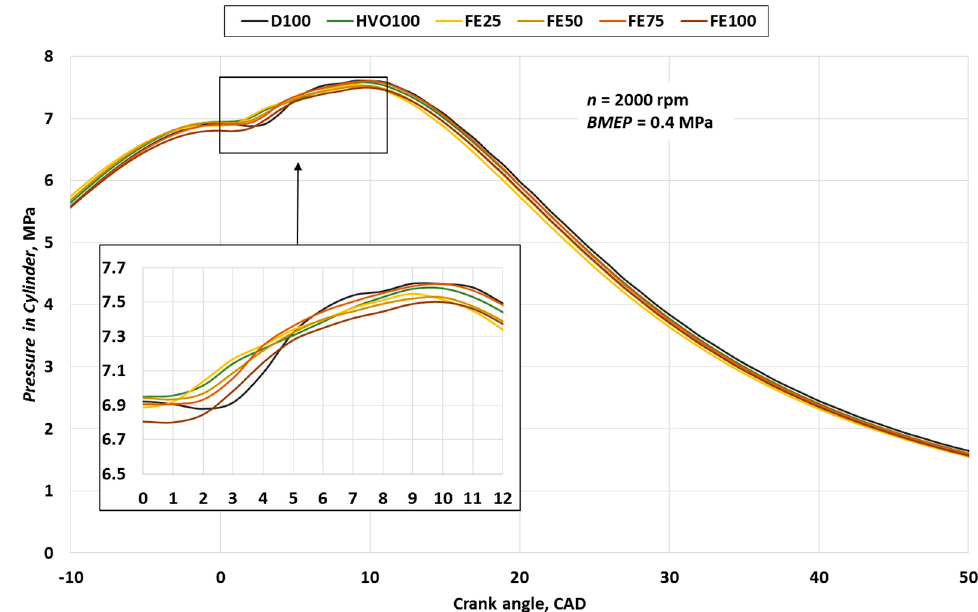
Figure 5. Pressure in the cylinder depending on the CAD.